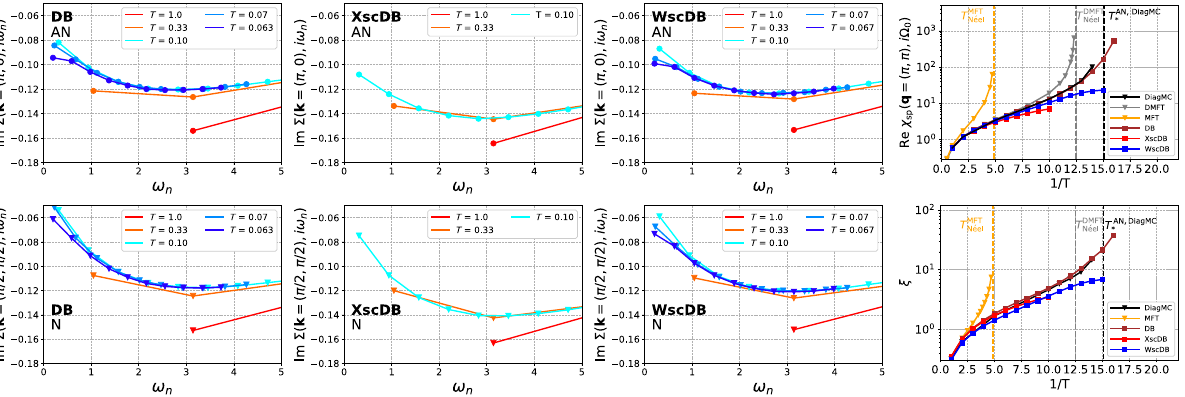
DiagMC.FIG. 36. Results from alternative DB schemes — single-shot (DB), self-consistent (XscDB), and W-self-consistent (WscDB) — for various